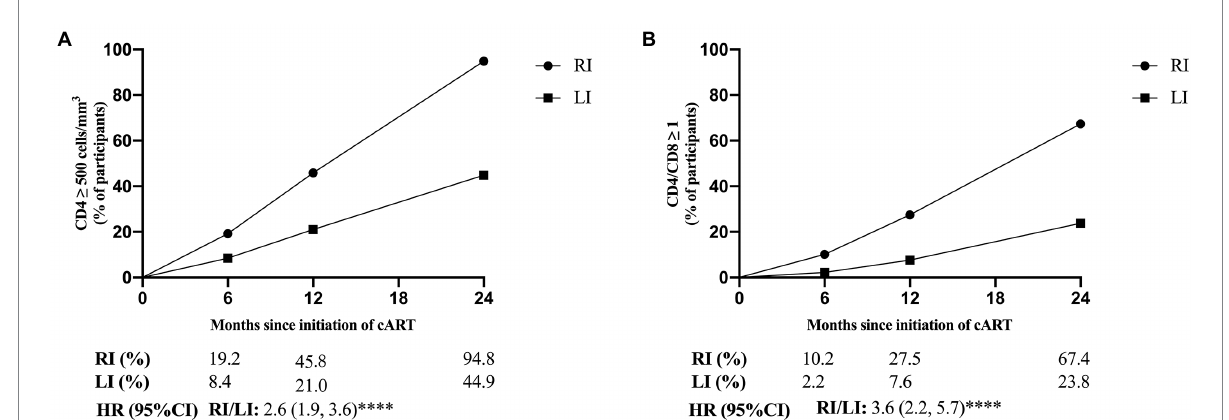
FIGURE 3 The proportion of CD4 + T-cell count ≥ 500 cells/mm 3 and CD4/CD8 ratio ≥ 1 for HIV-1 patients with recent and long-term HIV-1 infections after cART. CD4 + and CD8 + T-cell counts (A) and the ratio of CD4/CD8 (B) were detected in 200 cART-treated patients at different time points. RI, recent infection; LI, long-term infection; HR, hazard ratio; * , p < 0.05; ** , p < 0.01; *** , p < 0.001; **** , p < 0.0001; ns, p > 0.05.